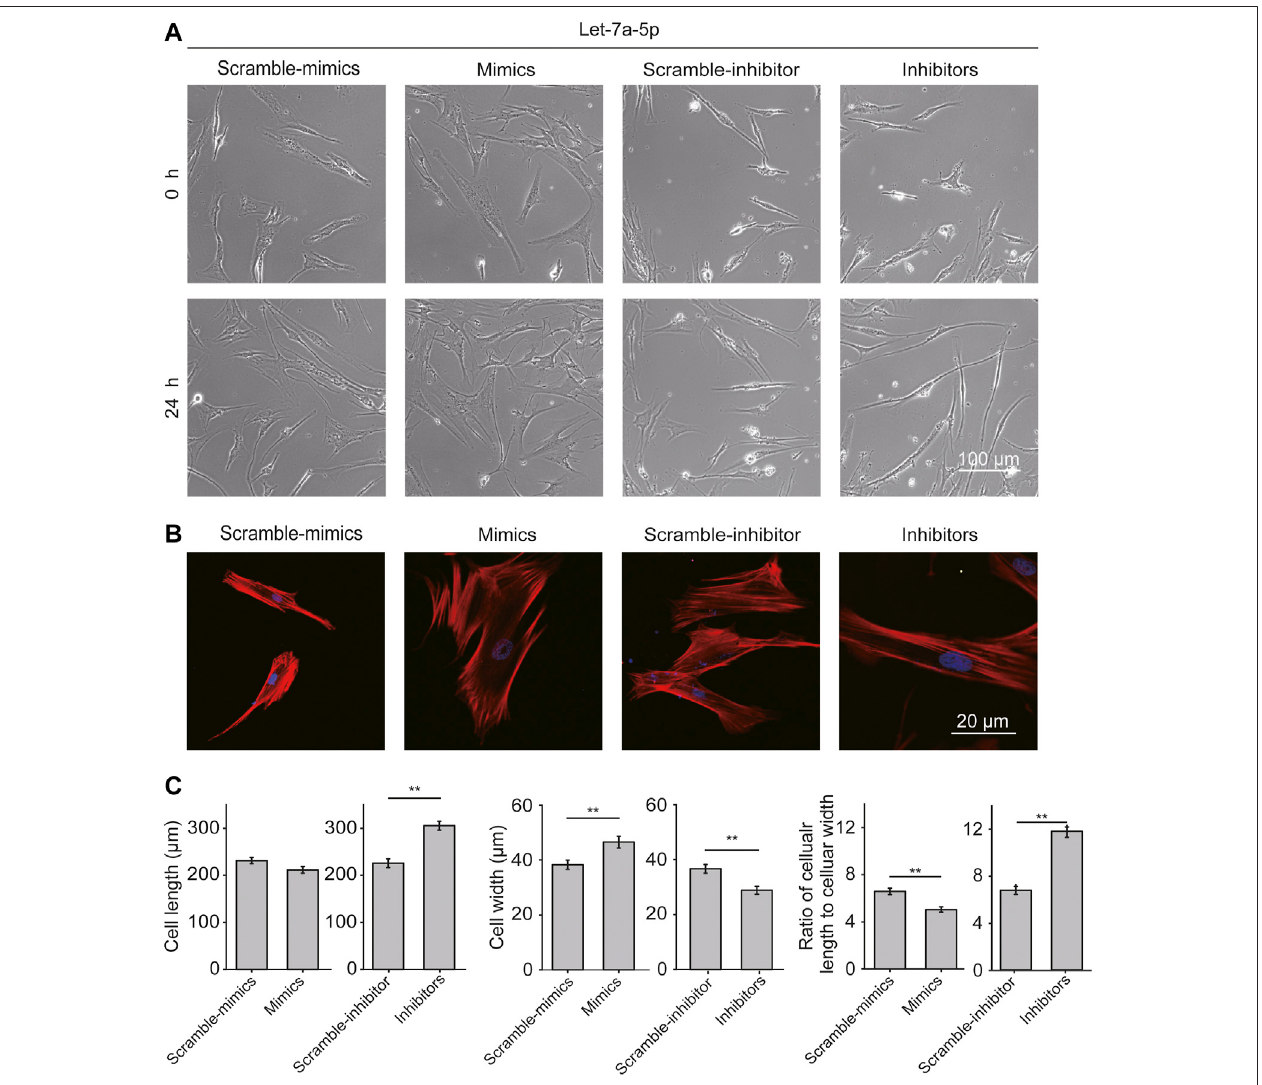
FIGURE 2 | Let-7a-5p modulates cell morphology and stress fi ber distribution. (A) The representative images of ASMCs transfected with let-7a-5p mimics, inhibitors, and related scramble controls. Bar = 100 µm. (B) The representative images of stress fi ber in ASMCs. Stress fi bers of ASMCs were stained with TRITC- Phalloidin and DAPI, respectively, in red and blue colors. Images were taken by confocal microscope (63X). Bar = 20 µm. (C) The quantitative data ofcell morphology of ASMCs treated with let-7a-5p mimics, inhibitors, and related scramble controls. The cellular length and width were measured by ImageJ. Cell aspect ratio was de fi ned as the ratio of cellular length to cellular width (* p < 0.05, ** p < 0.01, n = 20).